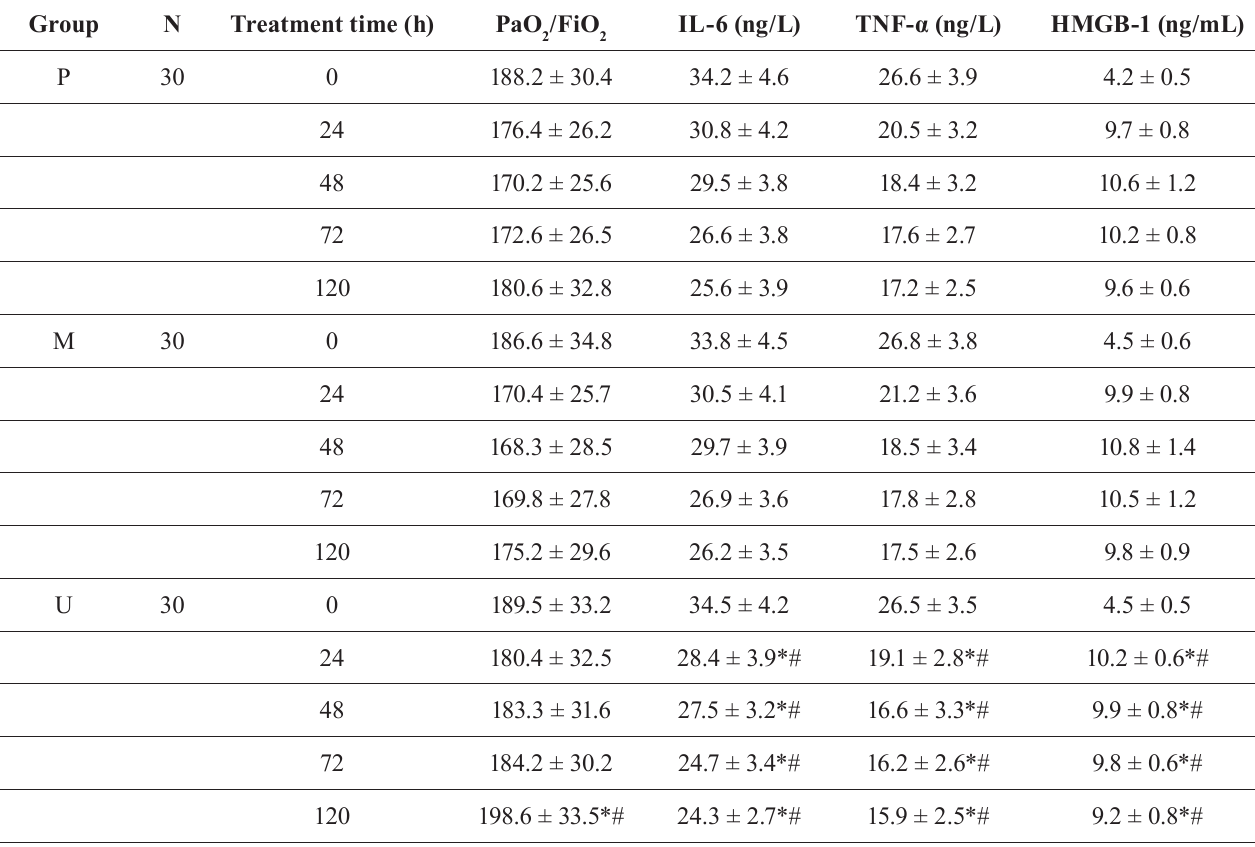
TABLE IV - Comparison of oxygenation and inflammatory cytokines before and after initiating sedation Group